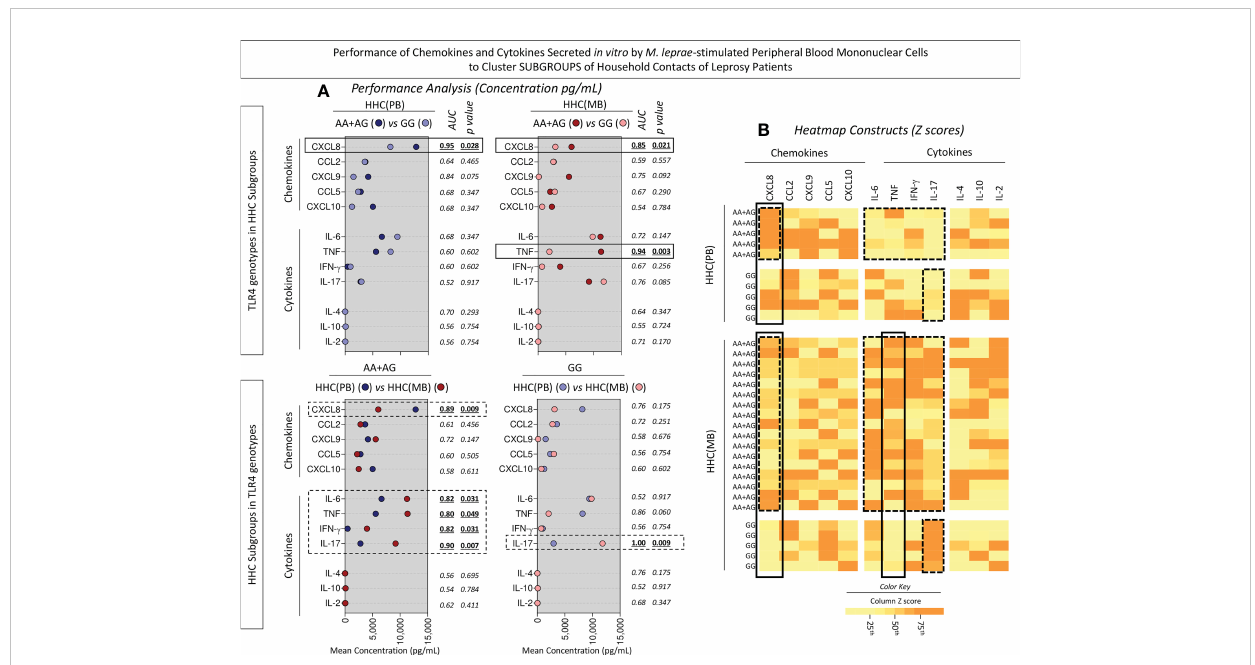
FIGURE 8 Performance of chemokines and cytokines secreted in vitro by M. leprae-stimulated peripheral blood mononuclear cells to cluster subgroups of household contacts of leprosy patients. The levels of chemokines (CXCL8, CCL2, CXCL9, CCL5, CXCL10) and cytokines (IL-6, TNF, IFN- g , IL-17, IL-4, IL- 10 and IL-2) were measured in the supernatant collected upon in vitro M. leprae-stimulated PBMC from household contacts of paucibacillary [HHC(PB), n =10] and multibacilary patients [HHC(MB), n = 23], further categorized according to the TLR4 rs1927914 genotype dominance model, as follows: AA +AG ( , n = 5; , n = 18, respectively) and GG ( , n = 5; , n = 5, respectively). (A) Quantitative analysis was performed by Cytometric Beads Array (CBA) according to manufacturer instructions. The results are expressed in pg/mL and presented in scatter plot, indicating the mean values. Comparative analysis between subgroups was carried out by Receiver-operating Characteristic Curves (ROC) and the Area Under the Curve (AUC) used as an indicator of global accuracy. Signi fi cant differences at p<0.05 are indicated by bold underline format. Biomarker with higher performance to cluster AA +AG from GG genotypes and HHC(PB) from HHC(MB) are underscored by continuous and dashed rectangles, respectively. (B) Heatmap constructs were assembled using conditional formatting in Microsoft Excel Of fi ce version 2016. A color key was employed to identify clusters of subjects with distinct (low or high) levels of chemokines and cytokines in each subgroup of household contacts of leprosy patients. The biomarkers able to cluster AA +AG from GG genotypes and HHC(PB) apart from HHC(MB) are highlighted by continuous and dashed rectangles,